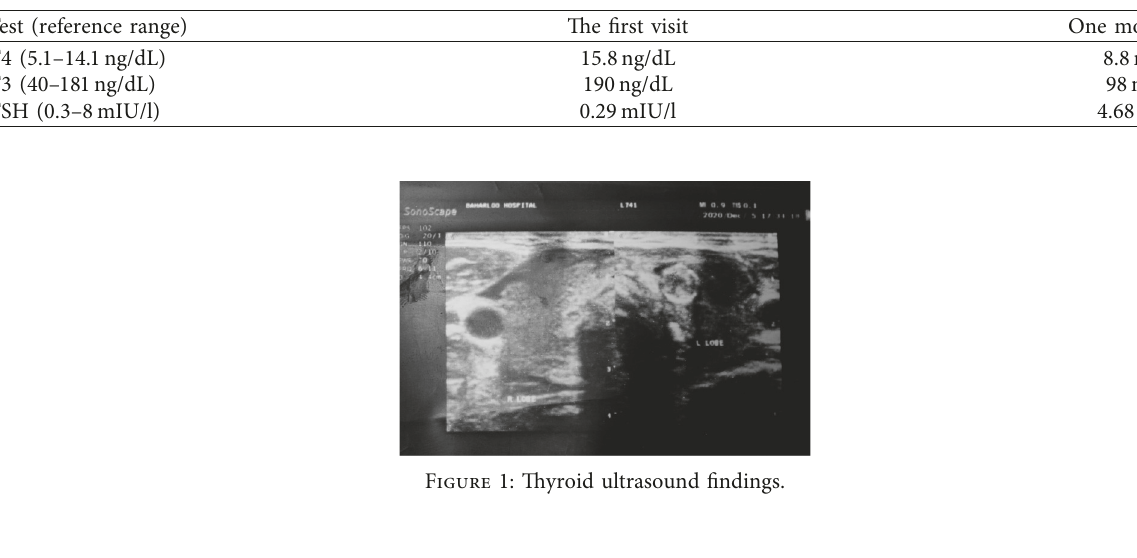
Table 2: TFT at multiple time points during the patient illness.